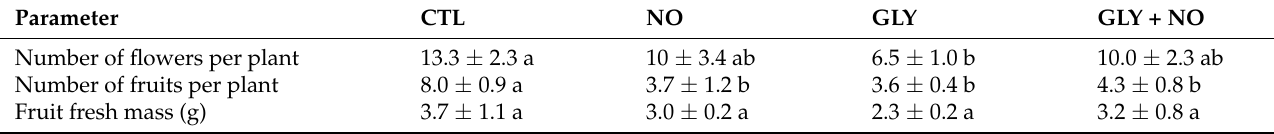
Table 3. Productivity-related characteristics of Solanum lycopersicum L. cv. Micro-Tom grown for 28 days in an artificial soil contaminated by GLY (10 mg kg − 1 ) and/or foliar sprayed with SNP (200 µ M). CTL—control plants, grown in the absence of GLY and foliar sprayed with dH 2 O once a week; NO—plants grown in the absence of GLY and foliar sprayed with SNP once a week; GLY—plants grown in the presence of GLY; GLY + NO—plants grown in the presence of GLY and weekly sprayed with SNP. Results are presented as mean ± standard deviation (SD) and result from the evaluation of at least three experimental replicates (n ≥ 3). Different letters indicate significant differences between groups (CTL, NO, GLY and GLY + NO) at p ≤ 0.05, according to the one-way ANOVA followed by Tukey’s post hoc test.